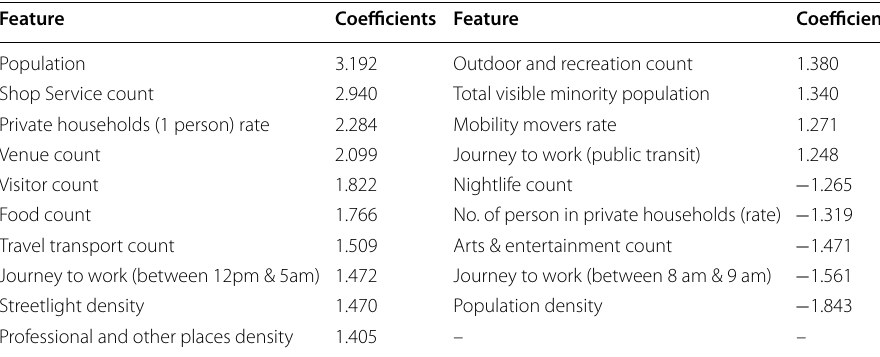
Table 10 Top 19 features with positive and negative coefficients